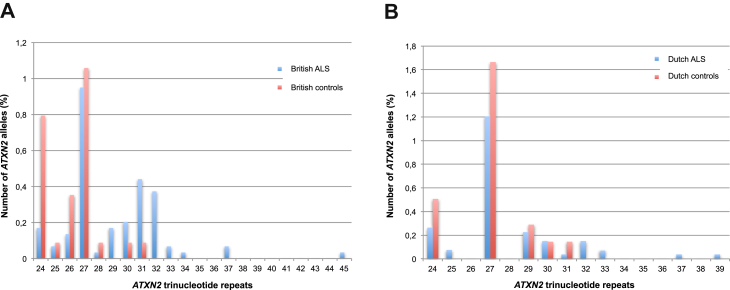
Distribution of ATXN2 alleles with trinucleotide repeat size 24 or more in the (A) British and (B) Dutch datasets. (A) The British dataset included 1474 ALS individuals and 574 controls. There were 2867 alleles of size 23 or less in cases and 1105 in controls. (B) The Dutch dataset included 1328 ALS individuals and 691 controls. There were 2596 alleles of size 23 or less in cases and 1344 in controls.